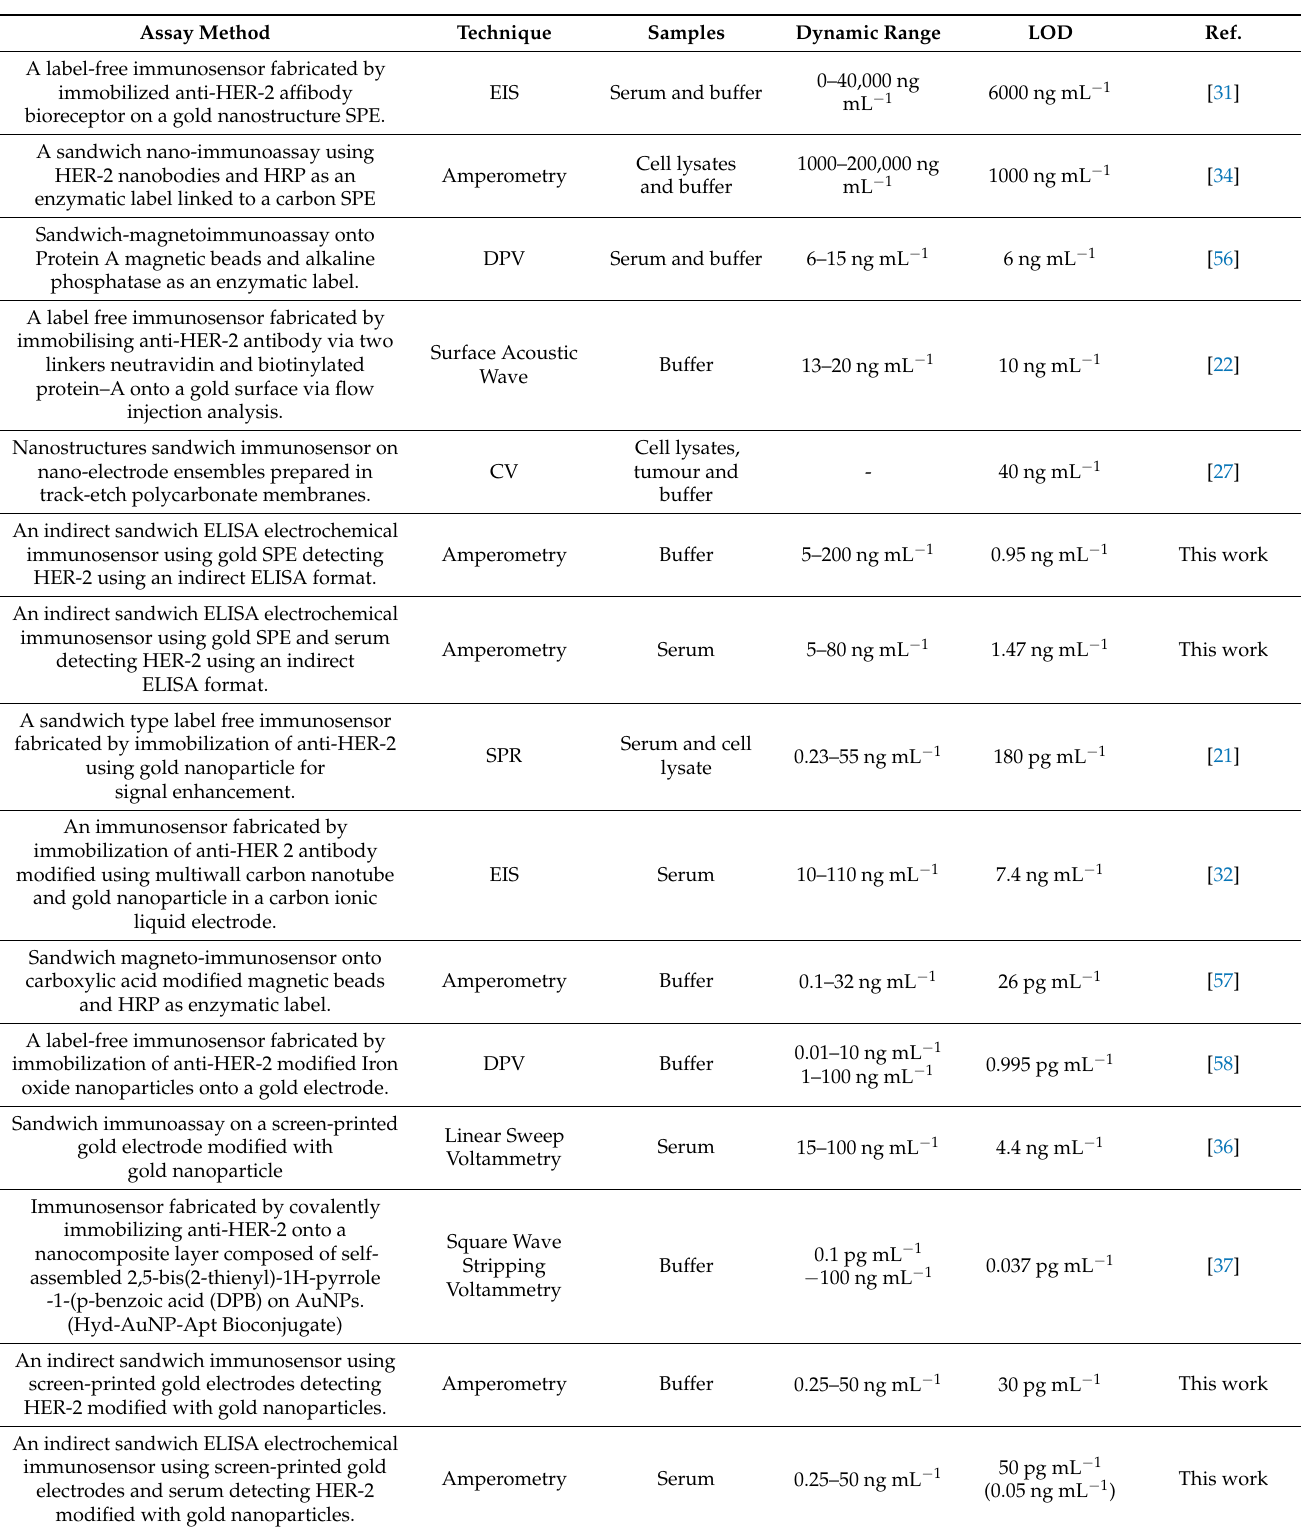
Table 2. Comparison of the performance of the sensor developed in this work for HER-2 with others reported in the